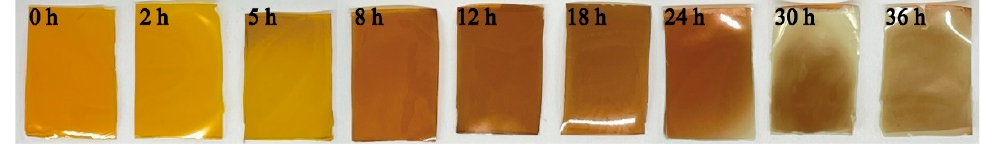
(3) Figure 7. Schematic diagram of sulfidation of AgNP. 3.4. Quality Indicating Performance of CNC-AgNP Film Figure 8 shows the color change of the neat CNC and CNC-AgNP films after contact with the chicken breast spoilage gas. The initial color remained unchanged up to 8 h, fol- lowing which a weak purple color appeared after 16 h in the case of the neat CNC film. In addition, studies have reported a color change in the visible-light range if moisture is ab- sorbed in the chiral nematic structure of CNC rods [34]. Thus, the color change of the neat CNC film can be attributed to the presence of moisture, and not H 2 S. However, no distinct color change was observed for any of the CNC-AgNP films up to this stage because no H 2 S had been generated, as shown in Figure 4. Color change in the C-0.22Ag film was first detected at 8 h into the experiment. The color change from reddish-brown to grayish yel- low was completed at 24 h. However, the films containing over 1.12 wt.% AgNP behaved differently compared to the C-0.22Ag film. The C-1.12Ag film brightened progressively by a marginal amount until 16 h, and a grayish stain was observed after 24 h. In the case of the C-2.25Ag and C-4.49Ag films, the color intensity decreased progressively until 8 h. Metal-like surfaces were observed in both films at 16 h, and a glossy surface was observed in the C-4.49Ag film after 24 h. As shown in Figure 8, all the CNC-AgNP composite films reacted sensitively with H 2 S and changed color. However, the C-0.22Ag film is the most promising for practical application owing to its higher Ag content, which results in a larger metallic surface.